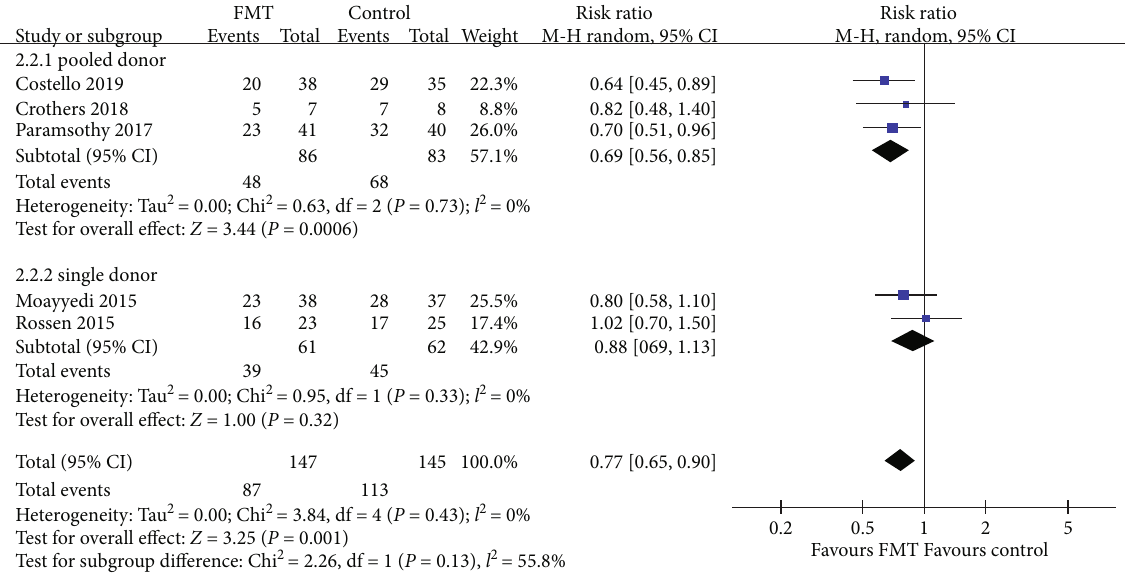
Figure 7: Forest plot of studies reporting clinical remission and subgroup analysis according to number of donors.